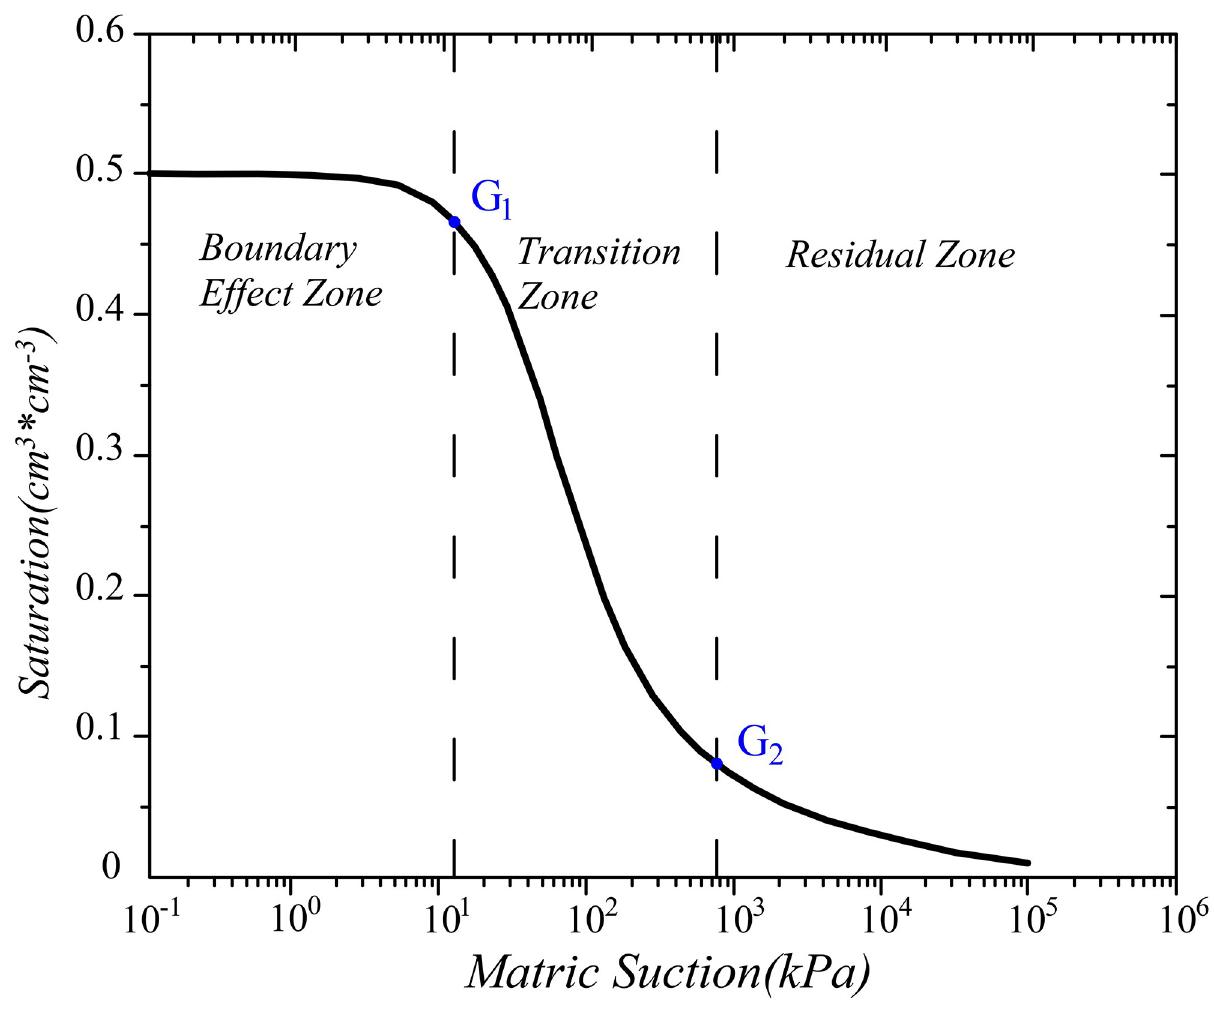
Fig 1. Typical soil-water characteristic